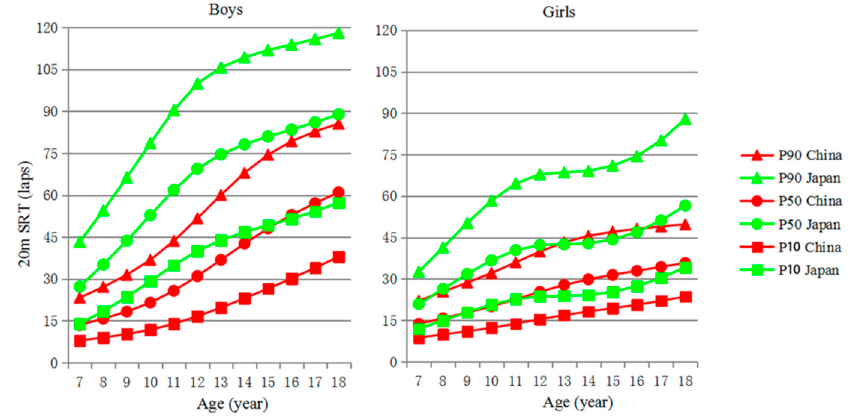
Figure 1. Centile curves for 20mSRT performances of Chinese and Japanese children and adolescents aged 7–18 years.